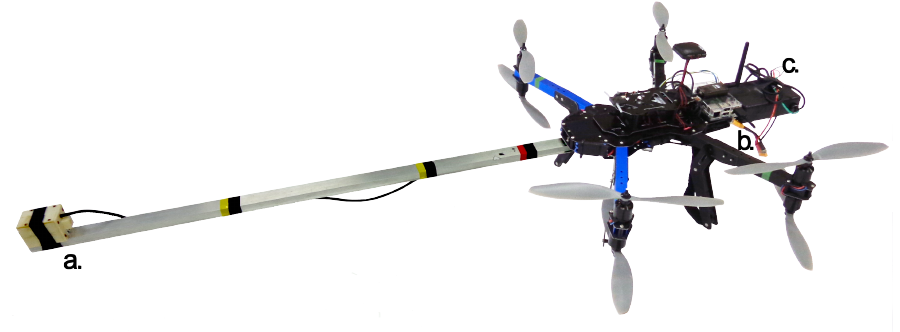
Figure 13. Close up of chosen Unmanned Aerial Vehicle (UAV): X8+ from 3DR. Important components are highlighted on the picture. ( a ) Sensor head with an 1.1m aluminium boom; ( b ) compainion computer: Raspberry Pi 2; ( c ) sensor